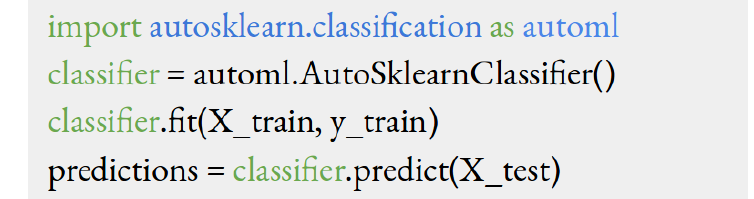
Figure 2. Python code for using Auto-Sklearn to train a classifier for any